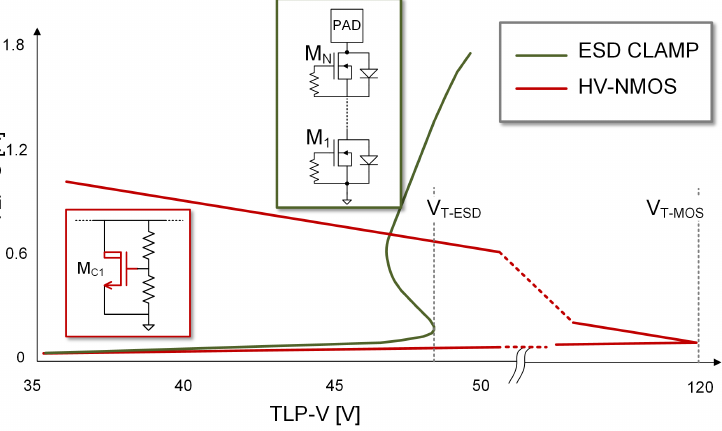
Figure 5. TLP characteristics of the ESD protection (green curve) and of the primary-clamp DNMOS M C 1 (red curve) in the interface circuit of Figure